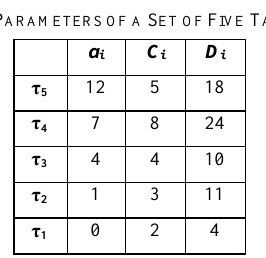
T HE P ARAMETERS OF A S ET OF F IVE T ASKS